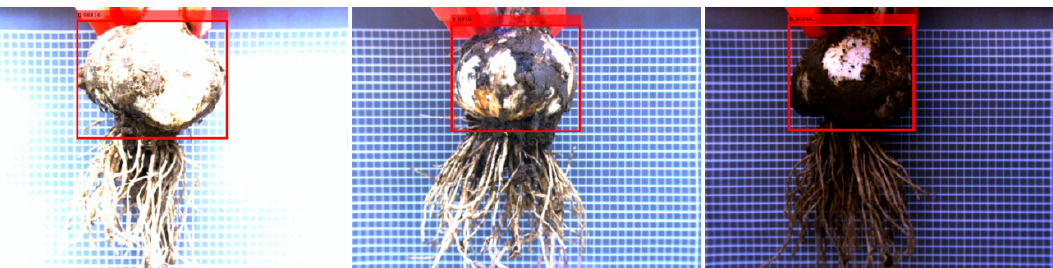
Figure 13. Detection results of IRM-YOLOv2 detector.